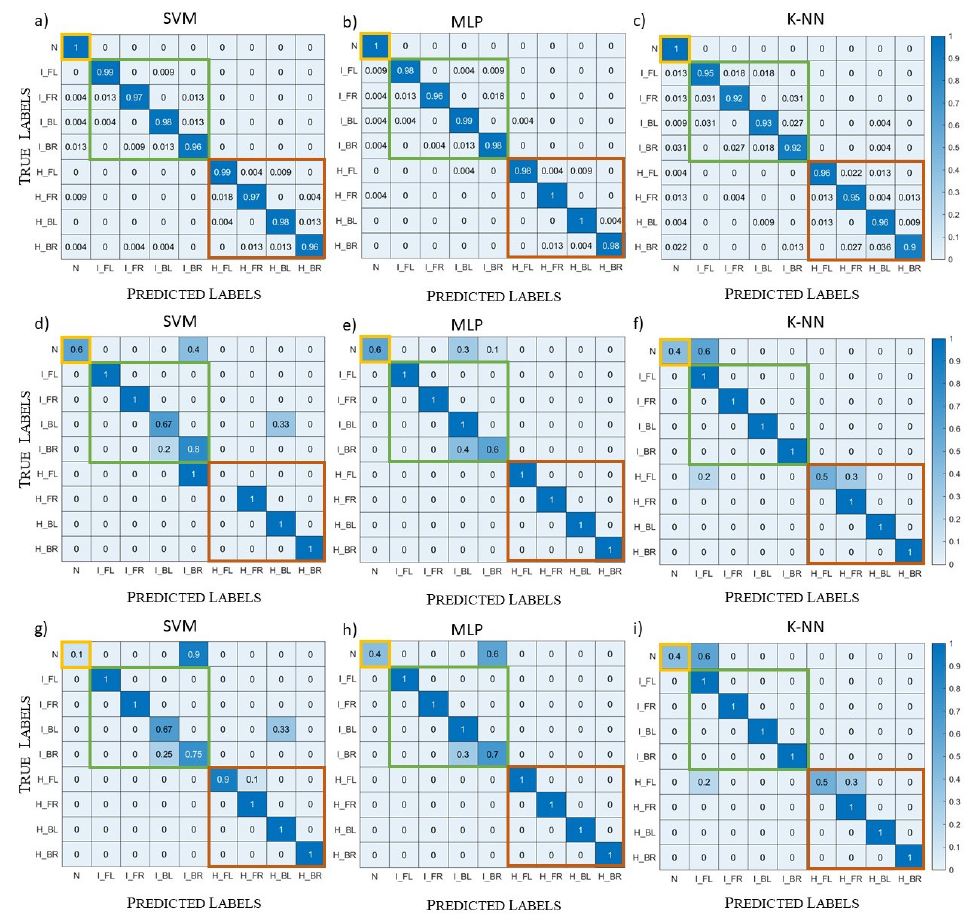
Figure 14. Normalized confusion matrices, amplitude dataset: ( a – c ) validation; ( d – f ) System A testing; ( g – i ) System B testing; ( a , d , g ) SVM results; ( b , e , h ) MLP results; ( c , f , i ) k-NN